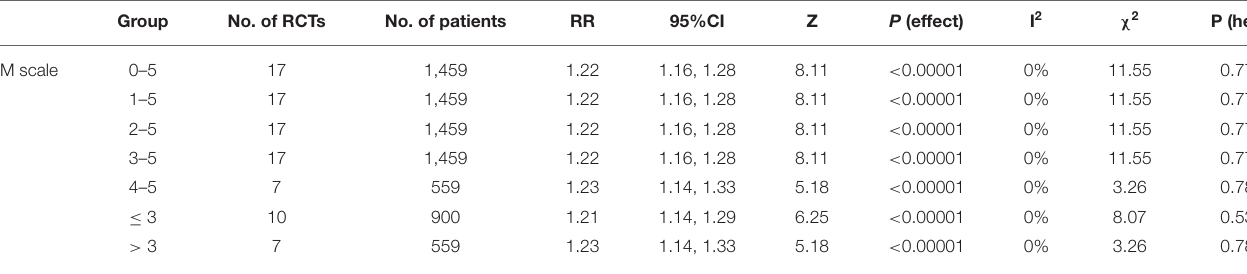
TABLE 3 | Sensitivity analysis based on the outcome measure